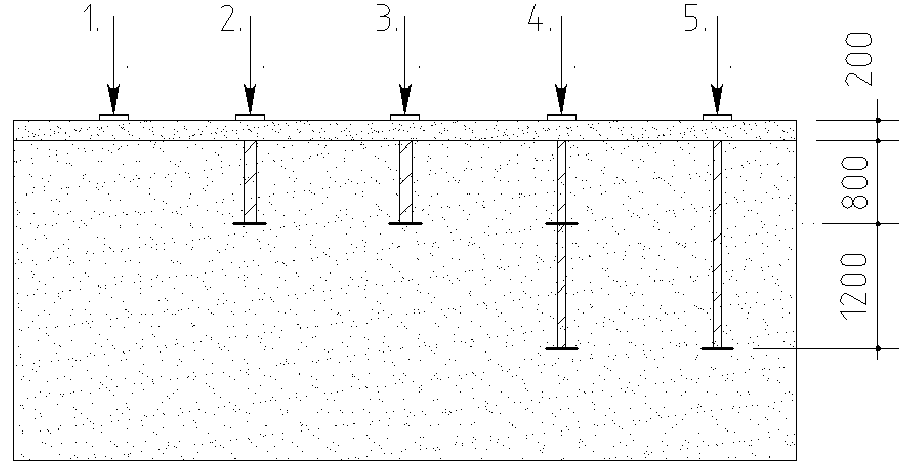
Figure 3. Scheme of the tested samples: (1) reference soil; (2–5) FRP-reinforced soil.